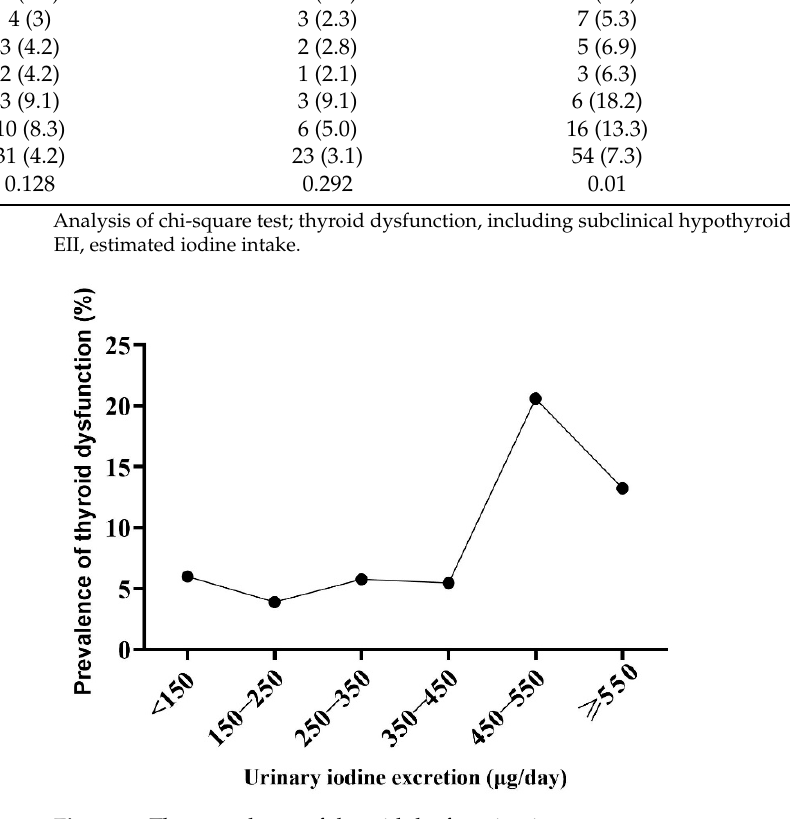
Figure 2. The prevalence of thyroid dysfunction in pregnant women among different urinary iodine excretion figures.